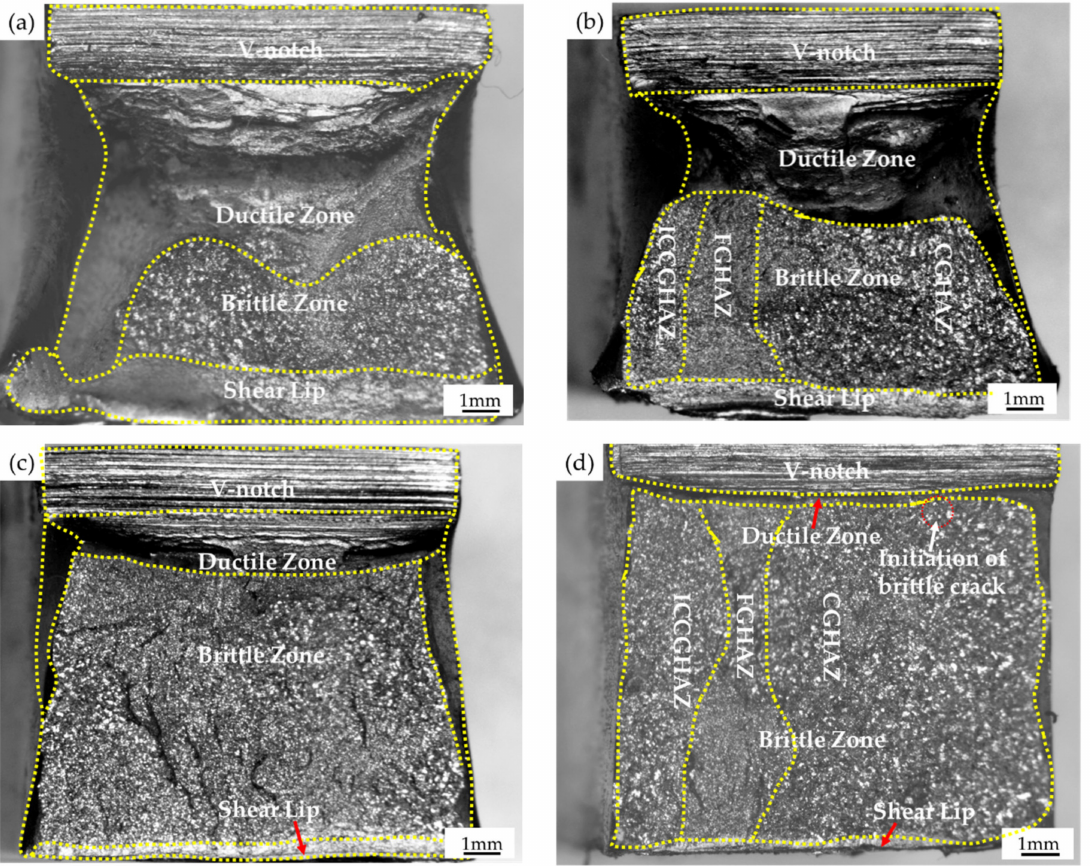
Figure 7. The macroscopic morphology of fracture surface in Group H II : ( a ) H II : 0 ◦ C-249 J; ( b ) H II : − 45 ◦ C-202 J; (c) H II : − 60 ◦ C-114 J; ( d ) H II : − 80 ◦ C-25